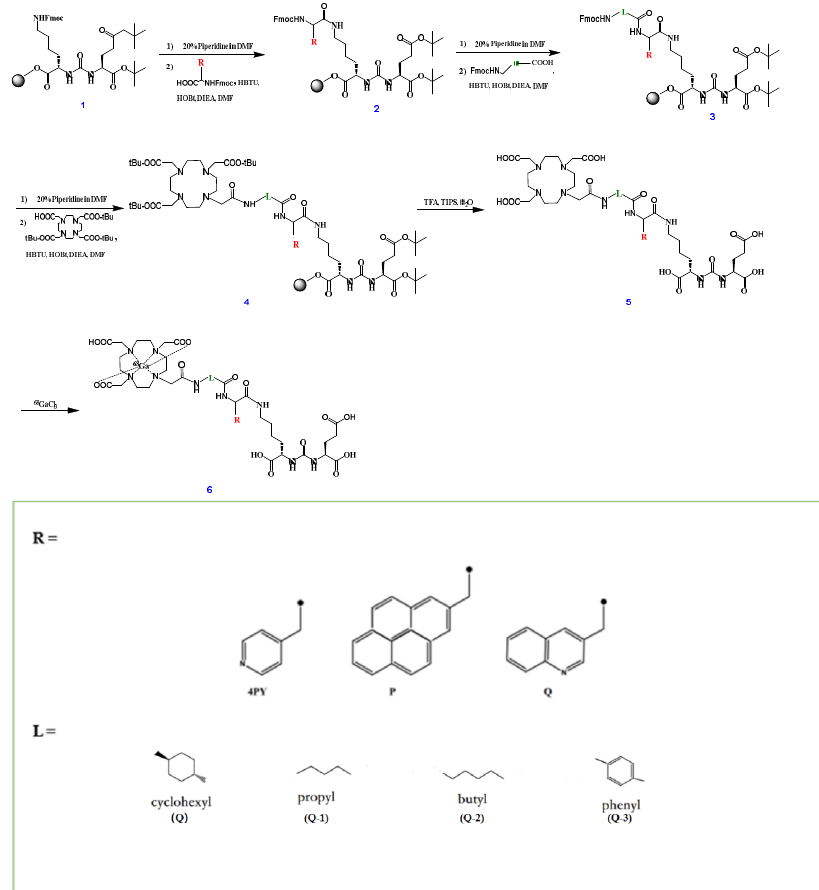
Scheme 1. Synthesis of novel PSMA tracers.